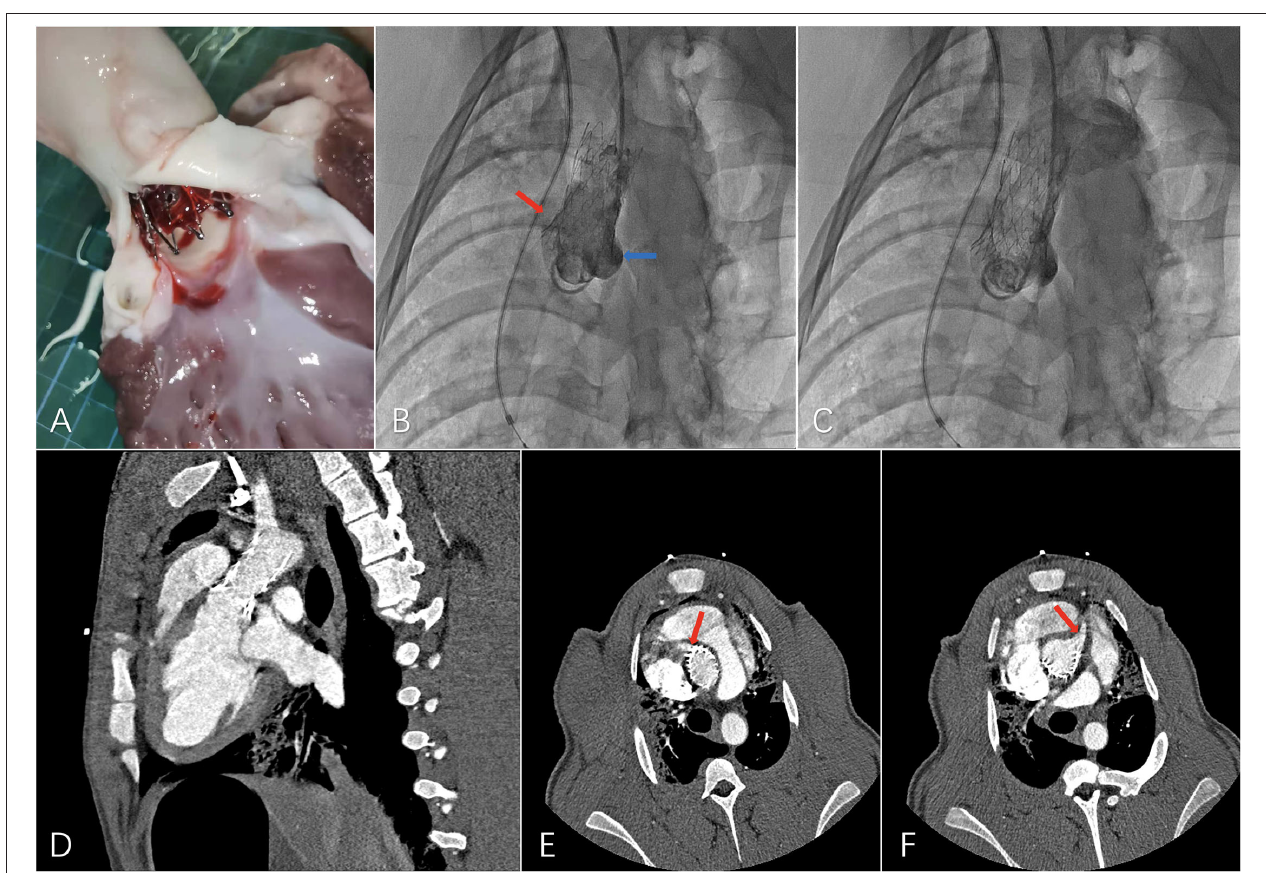
FIGURE 4 | Preliminary experiment with the novel ascending aortic endograft technique on a swine model. (A) Dissection after a 1-month period follow-up, (B) final angiography showing patent left (blue arrow) and right (red arrow) coronary ostia, (C) final angiography showing patent supra-aortic trunks, (D) computed tomography angiography (CTA) 1 month after the operation with, (E) patent right coronary ostium (red arrow), and (F) patent left coronary ostium (red arrow).